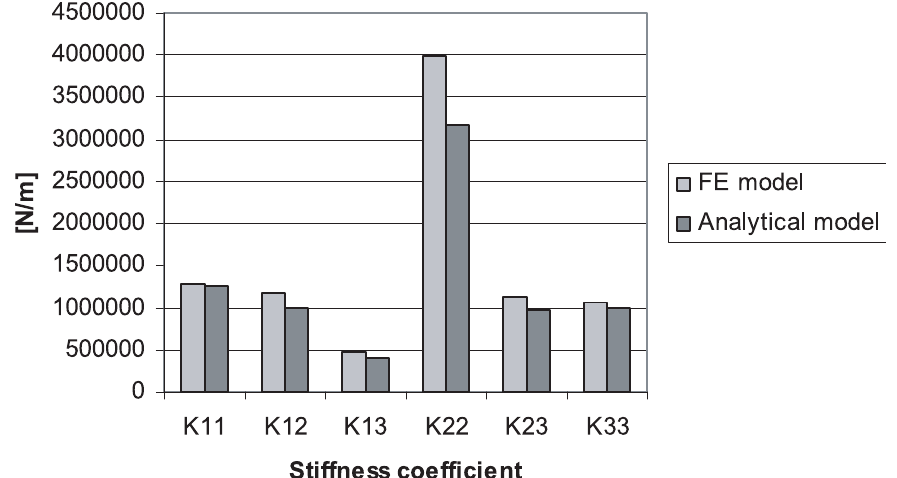
Fig. 9. Comparison between the stiffness coefficients corresponding to the updated FE model (Ref. [5]) and the analytical